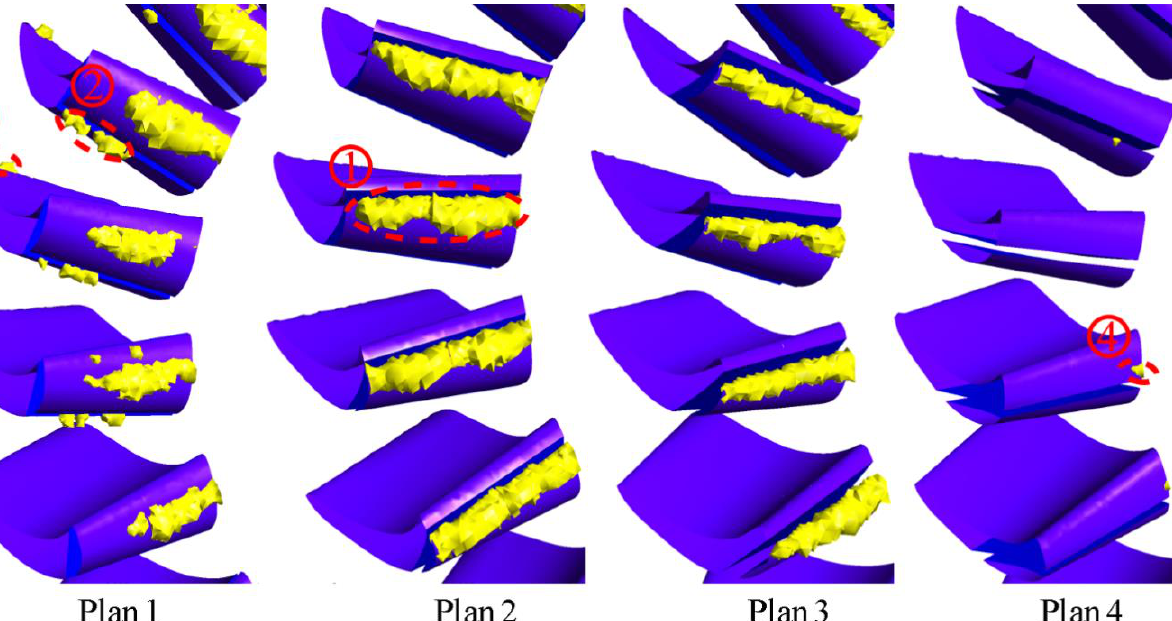
Figure 8. Comparison of time-averaged K and T bg with various suppression slots.